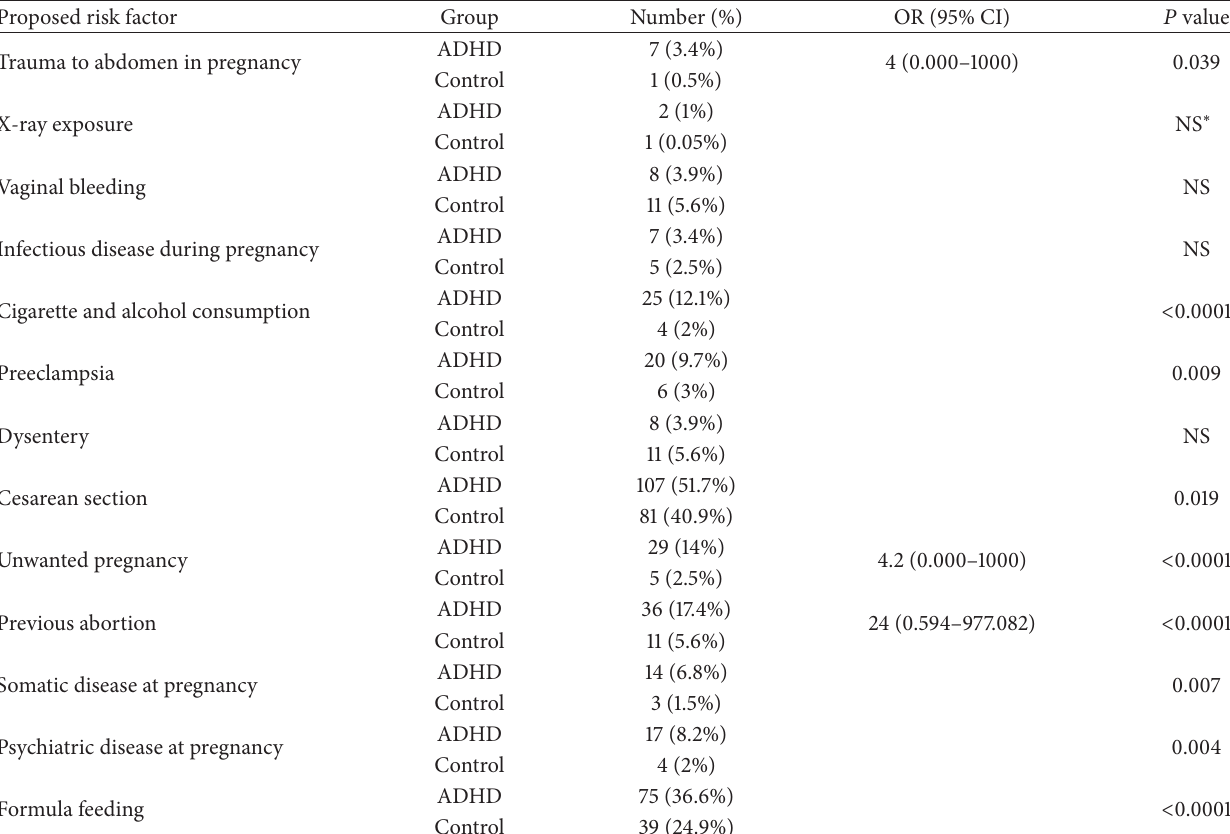
Table 1: Maternal, pregnancy, and neonatal risk factors for ADHD among case and control subjects.